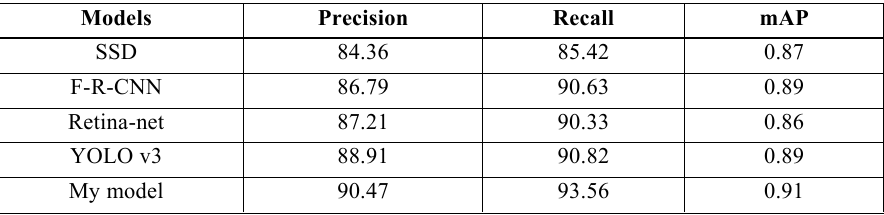
Table 2. Experimental results and comparison.